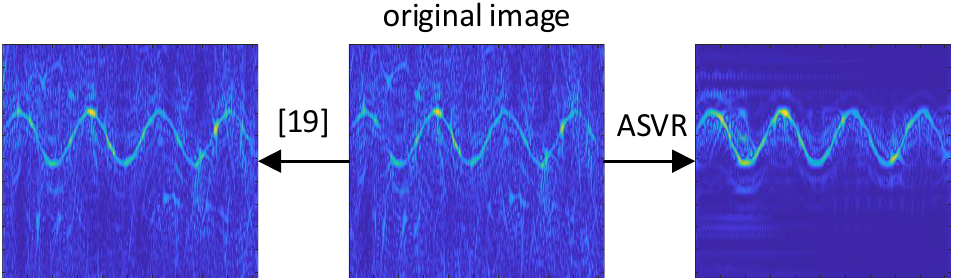
Figure 5. TFDIs of the raw signal at −6 dB and reconstructed signals based on ASVR and the method in [19].